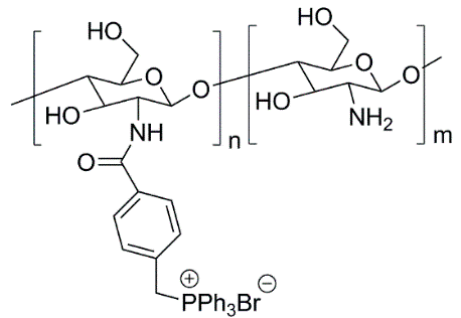
Figure 11. Structure of the chitosan derivatives bearing quaternary phosphonium salts used by Zhu et al. [155].